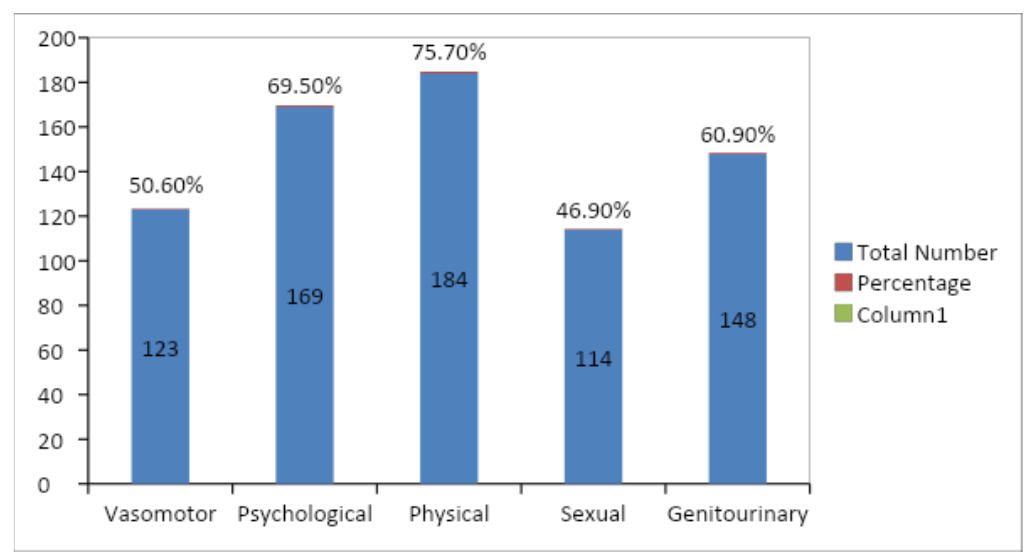
Figure 1: Categorization of major menopausal symptoms. The common vasomotor symptoms identified were sweating (n=114, 46.91%), hot flush (n=113, 46.5%) and night sweat (n=107, 44.03%). Heart discomfort or palpitation was identified among 96 (39.5%) patients.